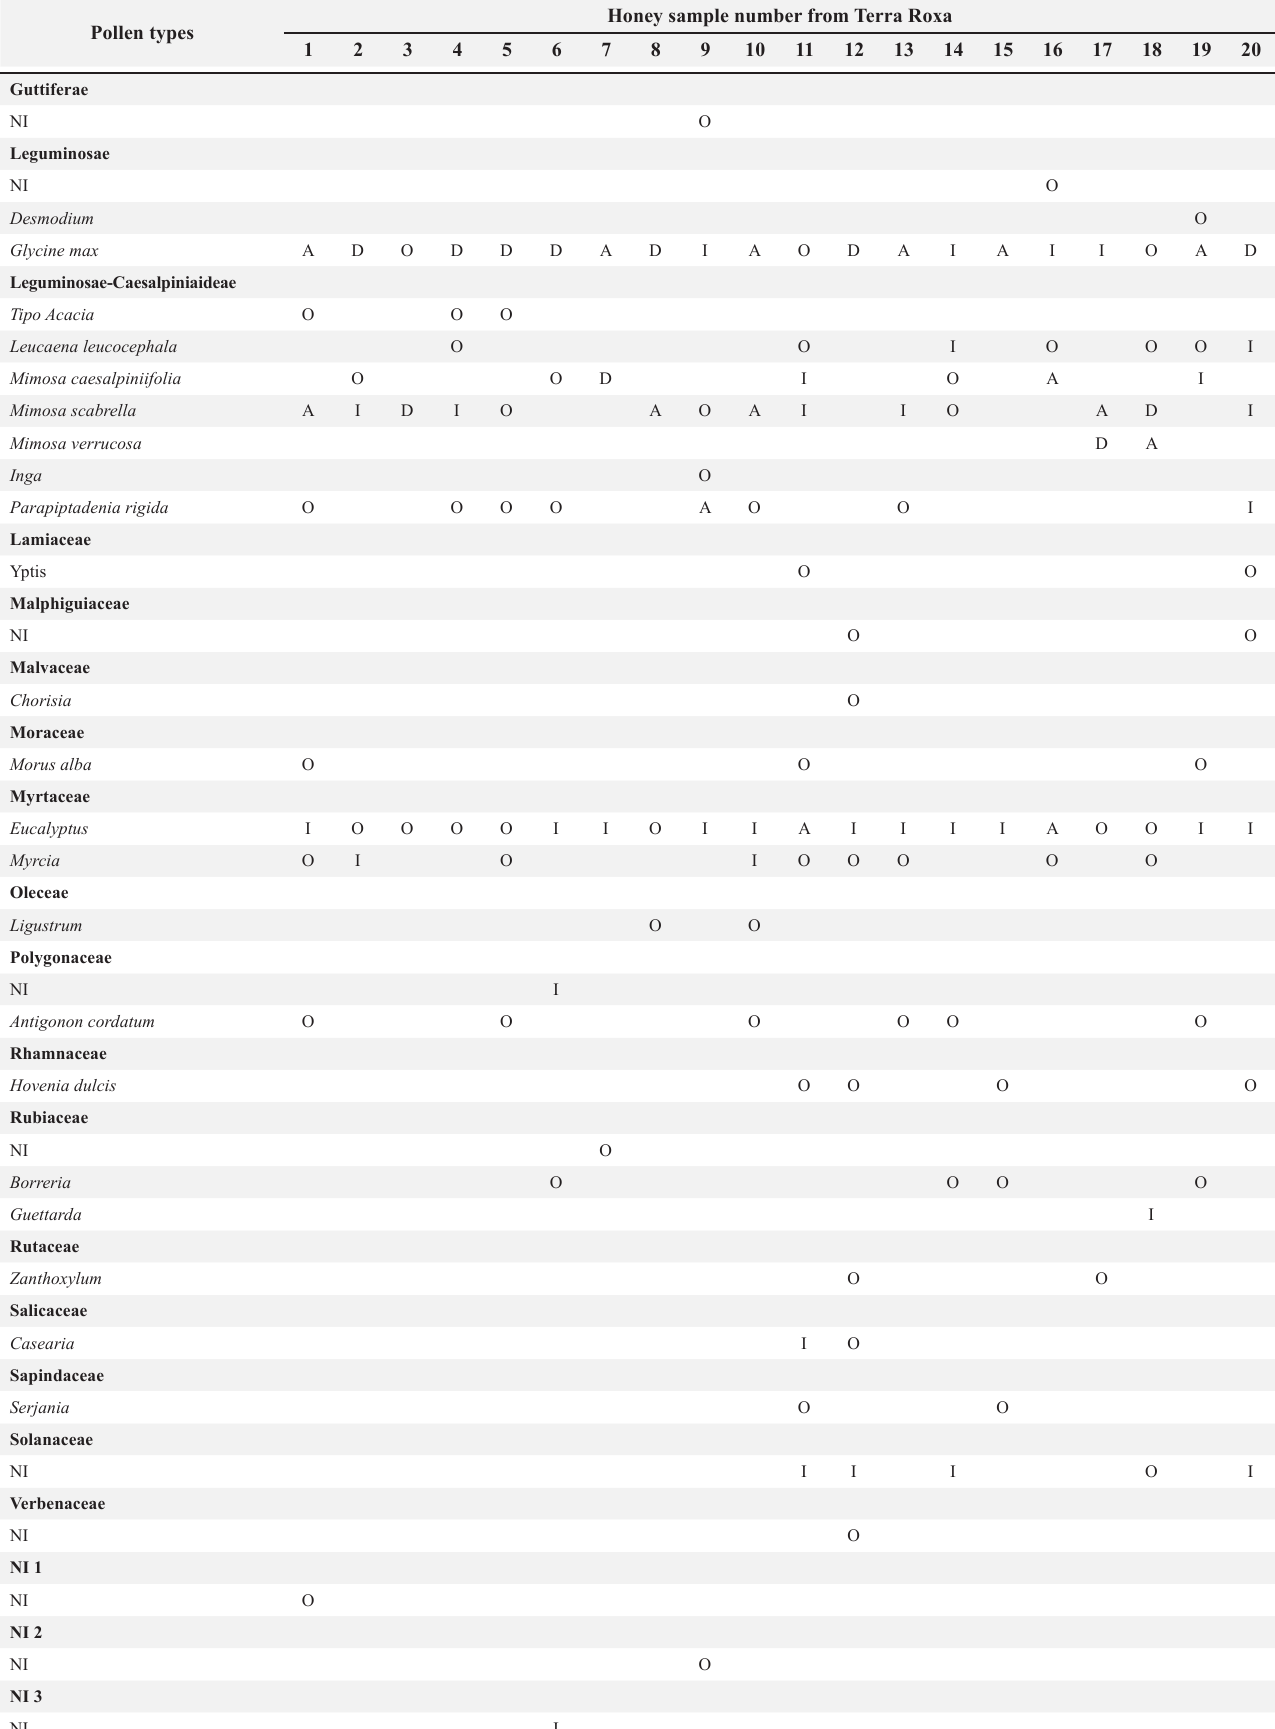
Table 2. Pollen types and frequency classes of: Terra Roxa honey sampless, where: D: dominant pollen (> 45%); A: accessory pollen (15–45%); I: important isolated pollen (3–5%); O: occasional isolated pollen (<3%); NI: not identified. (Continuation) Pollen